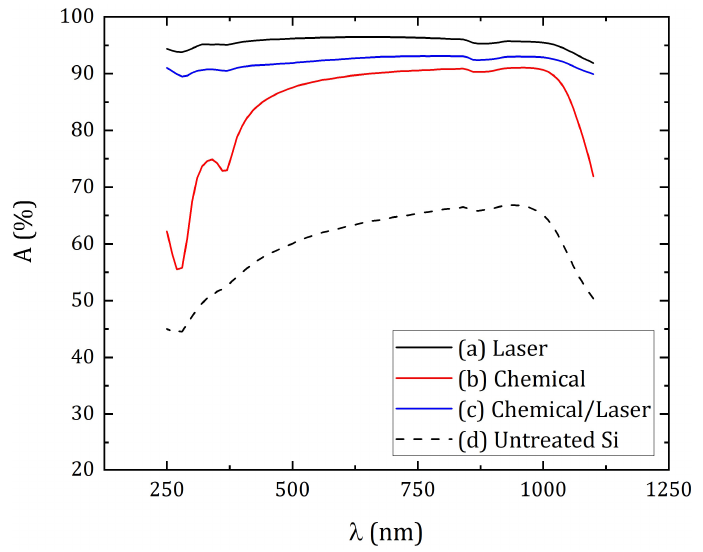
Figure 5. Absorptance of silicon surface: ( a ) Sample #1—laser texturing of a silicon cut; ( b ) Sample #2—chemical etching; ( c ) Sample #3—hybrid chemical/laser fabrication; ( d ) Untreated Si.